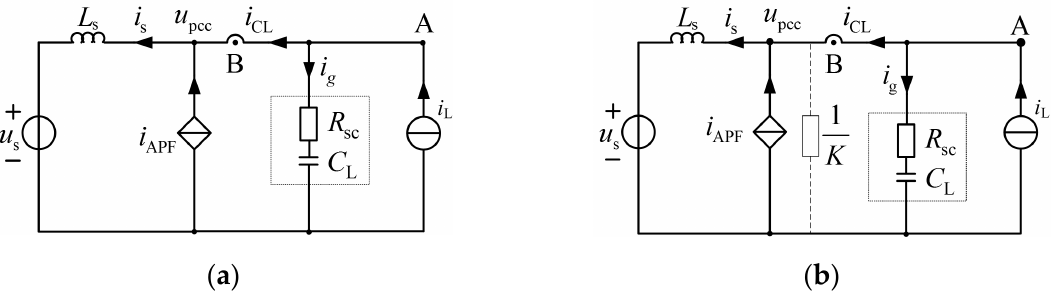
Figure 7. The system’s single-phase equivalent circuit ( a ) without virtual damping; ( b ) with virtual damping.